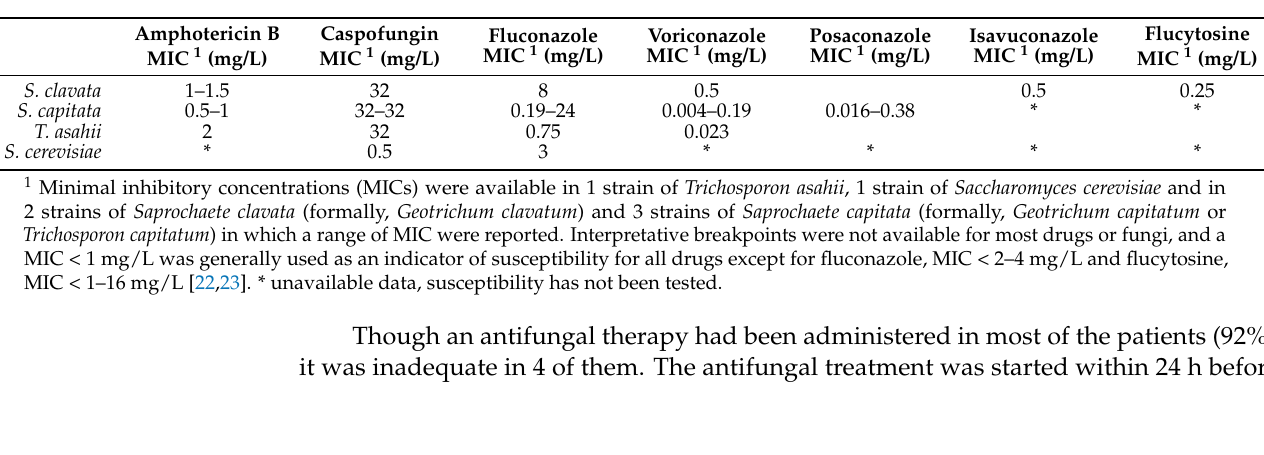
Table 3. Antifungal therapy susceptibility testing of emerging molds in the study